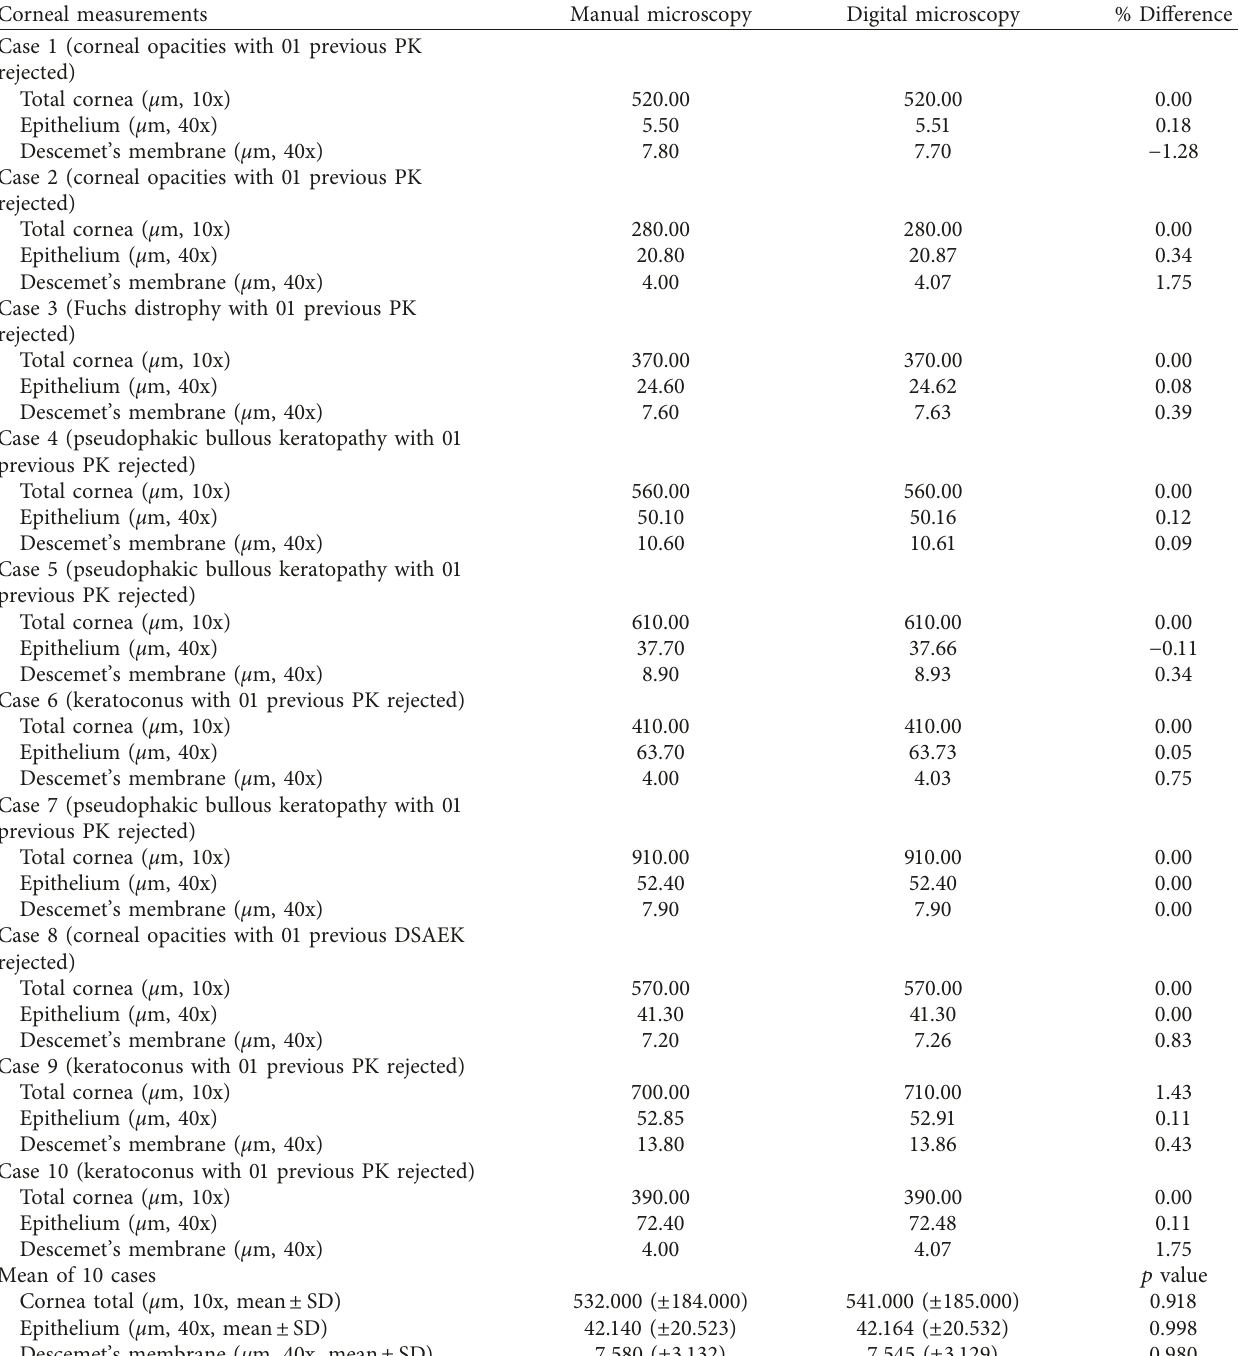
Table 4: Internal validation: comparison between corneal measurements obtained by manual microscopy only and by digital microscopy on 10 corneas from failed grafts stained with periodic acid-Schiff (PAS). Corneal measurements Manual microscopy Digital microscopy %